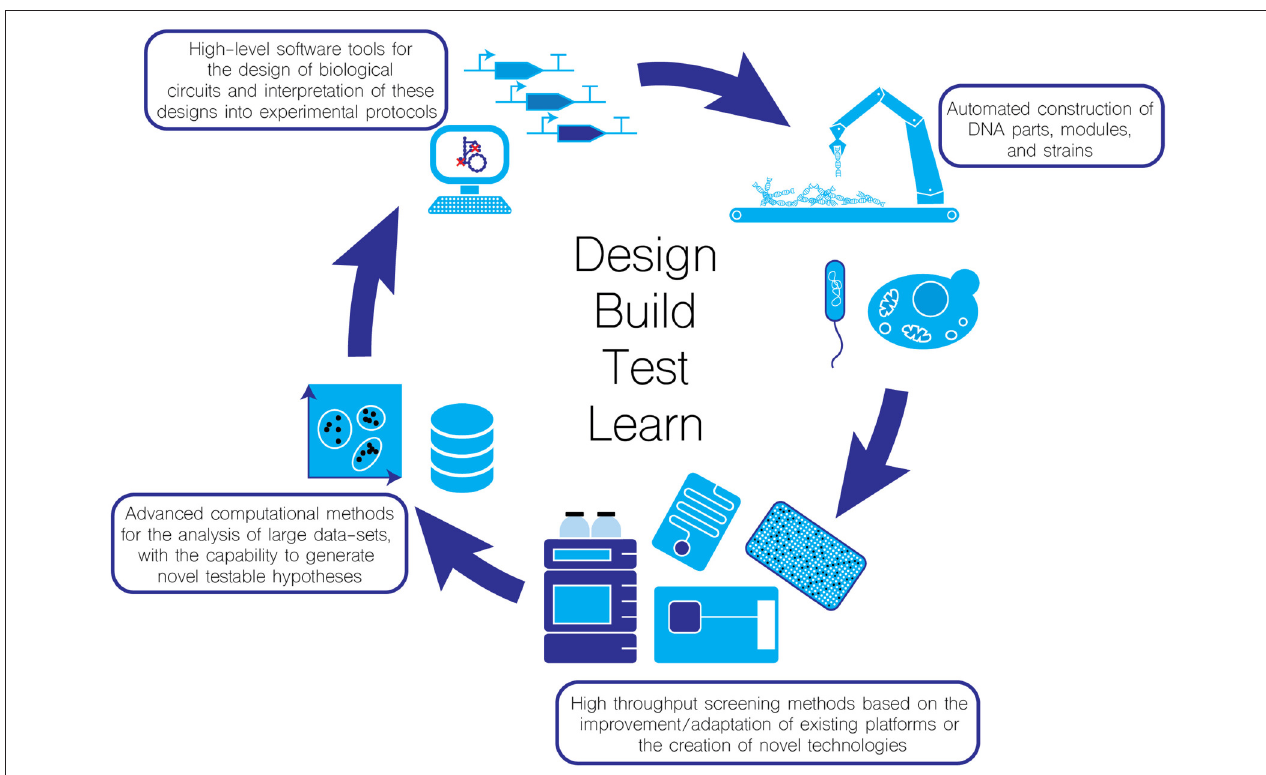
FIGURE 1 | Moving towards automation in the Design-Test-Build-Learn cycle for enhancing the throughput and reliability of biological